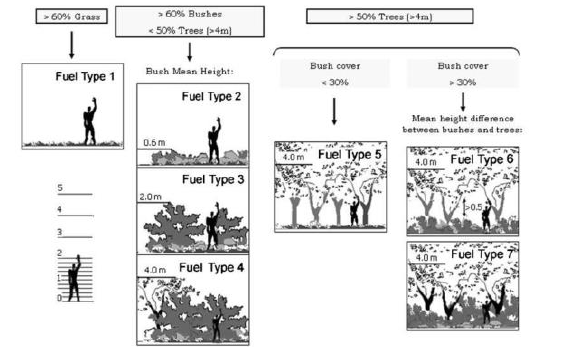
Figure 7b. Fuels classified by Prometheus model in 2016.